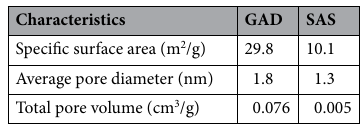
Table 1. The physical properties of GAD and SAS.